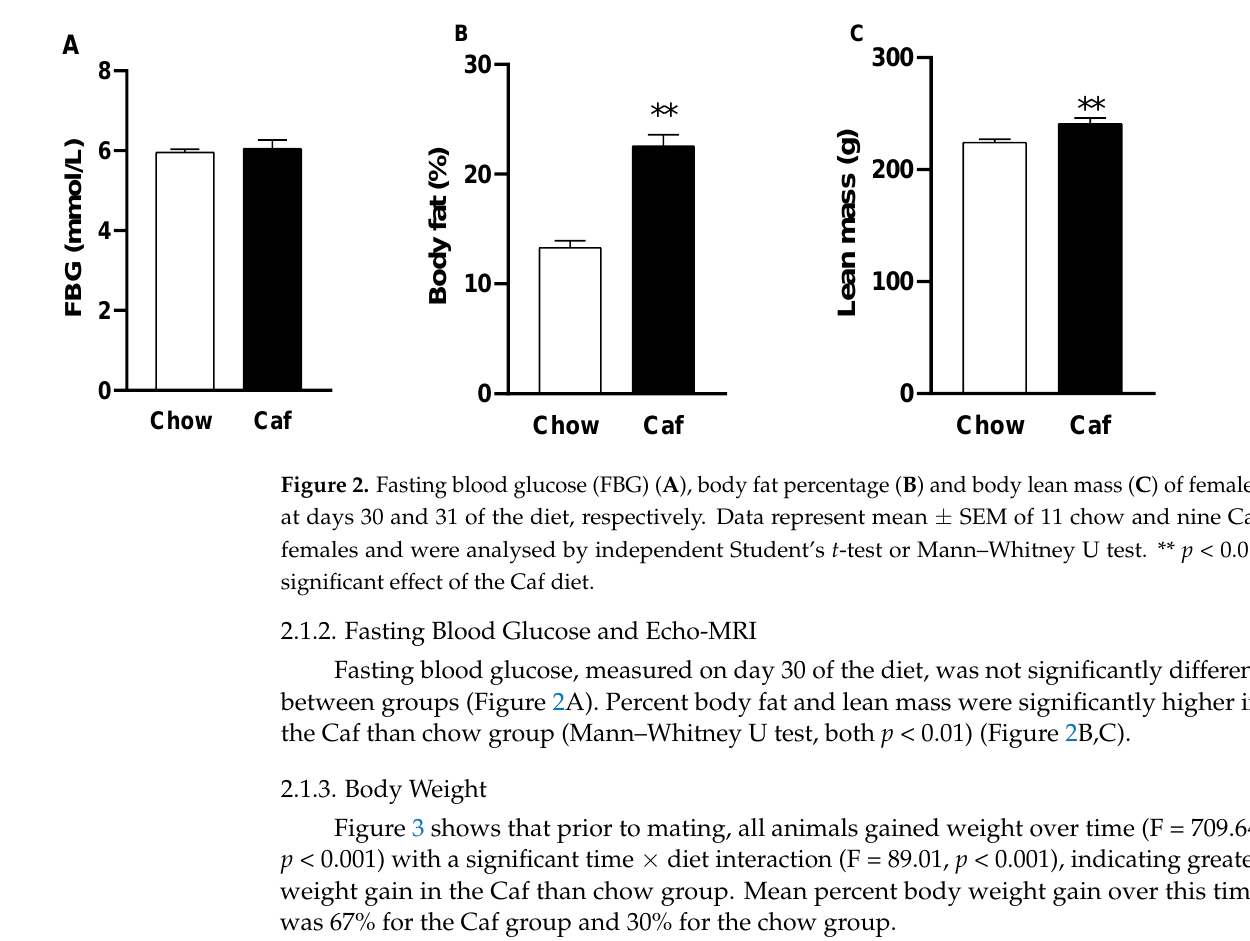
Figure 1. The 24 h energy intake (kJ/rat/day) in chow and Caf rats prior to mating ( A ). Data represent mean ± SEM of 15 chow and 21 Caf females, housed three per cage. Intake of diet component sub- groups (chow, solid Caf, and liquid sucrose) in Caf females as percent total kJ is shown in ( B ). Over- all macronutrient intake in chow and Caf groups ( C ) as well as macronutrient intake over time ( D – F ) is shown. Data were analysed by mixed ANOVA. ** p < 0.01, significant effect of Caf diet.